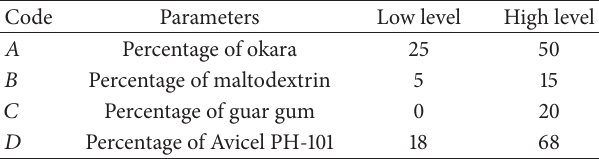
Table 1: Parameters studied in physical optimization of okara tablet.